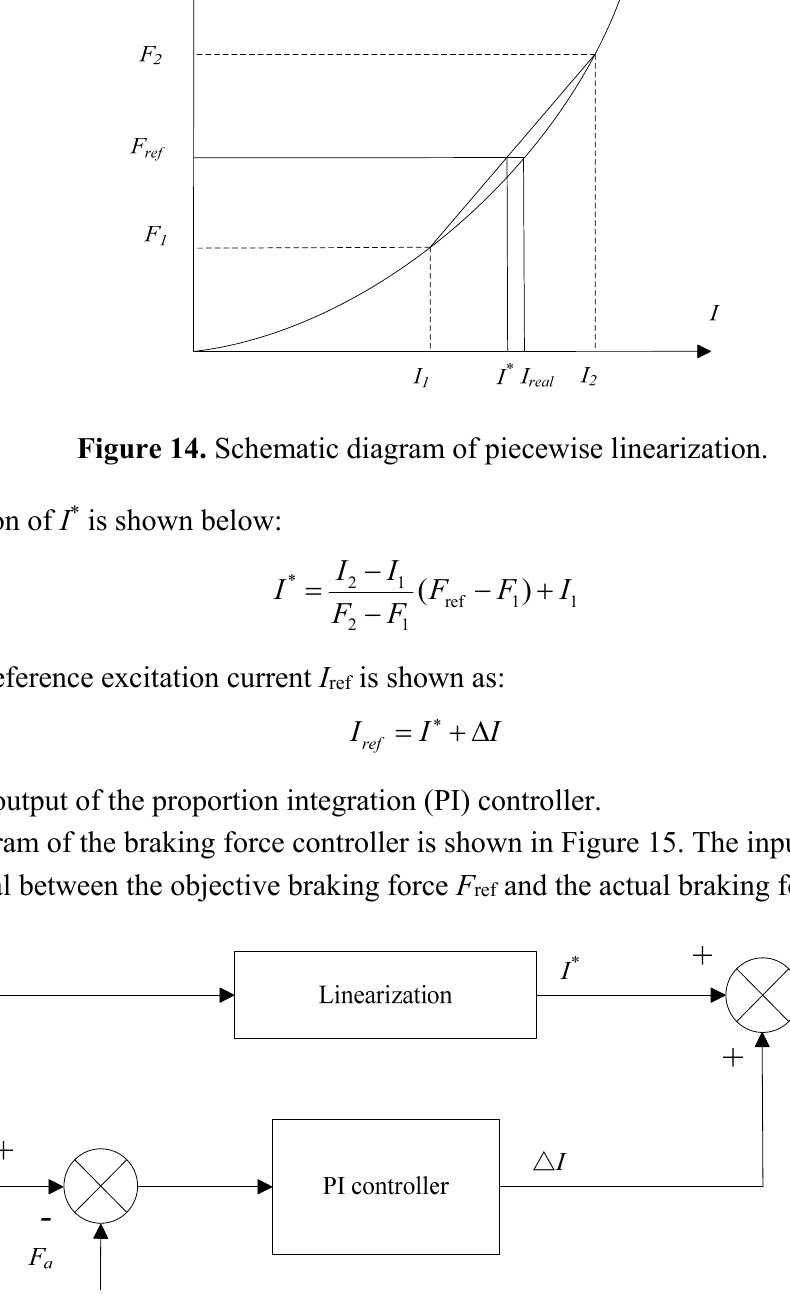
Figure 15. Block diagram of the braking force